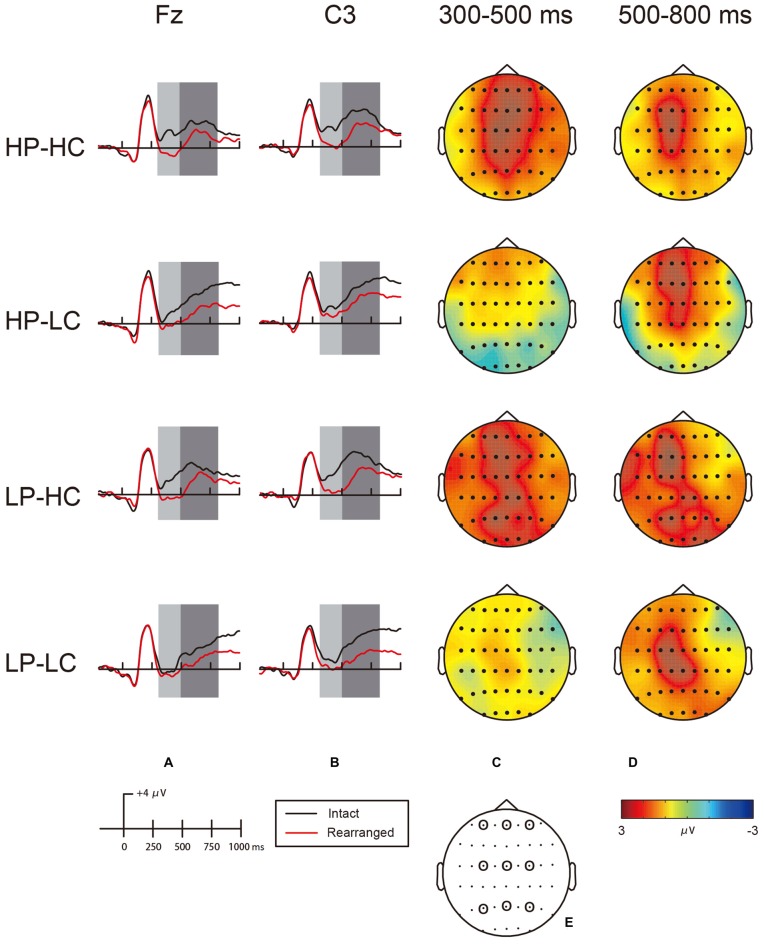
(A) Event-related potential (ERP) waveform for HP-HC, HP-LC, LP-HC and LP-LC at electrodes Fz in the 300–500-ms early time window (light bars) and the 500–800-ms time window (dark bars). (B) ERP waveform for HP-HC, HP-LC, LP-HC and LP-LC at electrodes C3 in the 300–500-ms early time window (light bars) and the 500–800-ms time window (dark bars). (C) Topographic maps illustrating the distribution of associative recognition differences (intact minus rearranged trials mean amplitudes) for HP-HC, HP-LC, LP-HC and LP-LC conditions during the 300–500-ms early time window. (D) Topographic maps illustrating the distribution of associative recognition differences (intact minus rearranged trials mean amplitudes) for HP-HC, HP-LC, LP-HC and LP-LC conditions during the 500–800-ms late time window. The scale bar in the bottom of the map indicates the maximum and minimum of the voltage range. (E) Schematic maps with the highlighted sites employed to analyze the intact/rearranged effects of 300–500-ms and 500–800-ms time windows. LF, left frontal (F3); MF, middle frontal (Fz); RF, right frontal (F4); LC, left central (C3); MC, middle central (Cz); RC, right central (C4); LP, left parietal (P3); MP, middle parietal (Pz); RP, right parietal (P4).